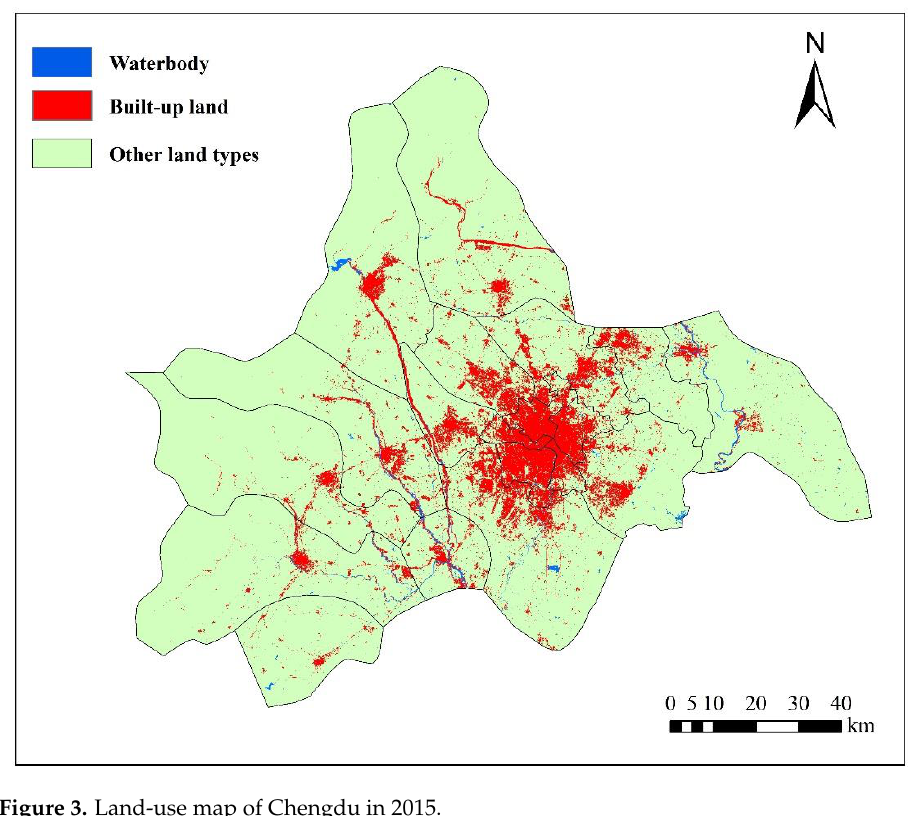
Figure 3. Land-use map of Chengdu in 2015.